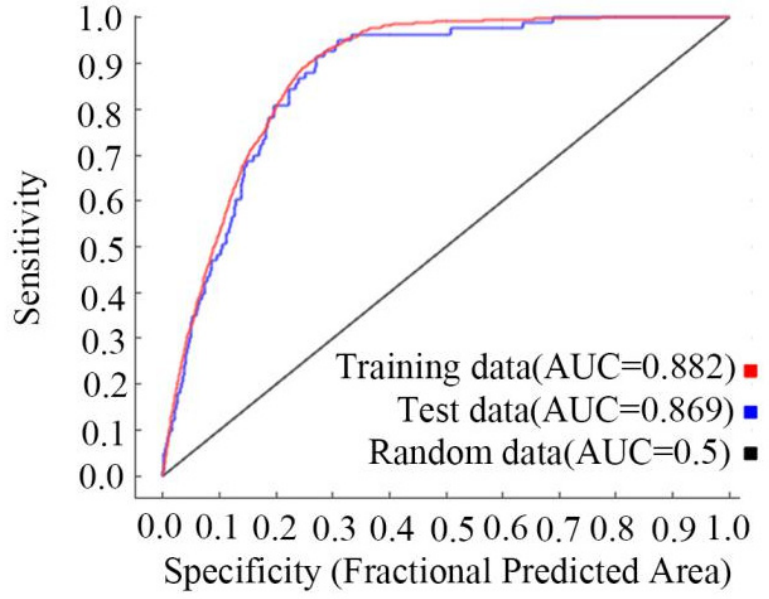
Figure 6. The ROC curve of combined mangrove species used to verify the MaxEnt model.